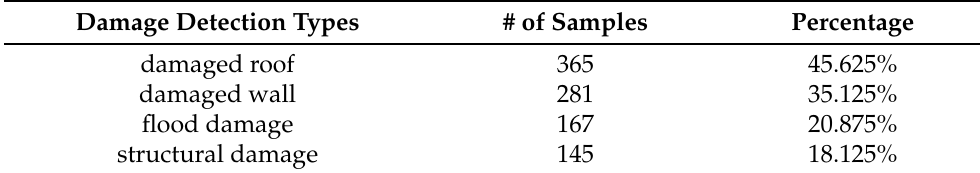
Table 2. Summary of images for the building damage detection task. The selected 800 images were divided into four categories to characterize damage inflicted upon different kinds of objects or structures by historical hurricanes. The total number of object samples of 958 is larger than the number of images (i.e., 800) due to the fact that an individual image can include multiple damaged